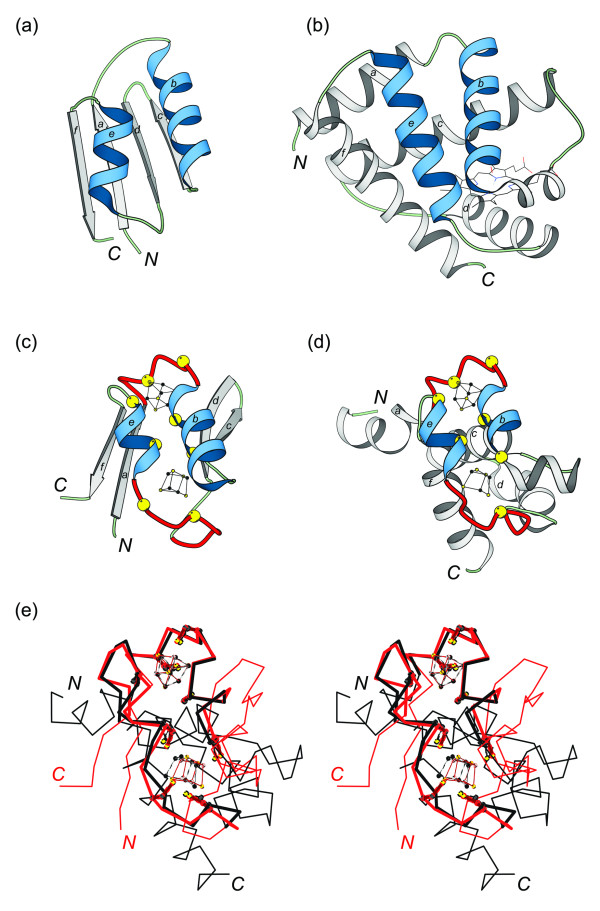
Structural comparison of the ferredoxin domains: Structural diagrams of (a) CheY-binding domain of CheA that belongs to the α+β ferredoxin-like fold (PDB: 1ffg, chain B) and (b) leghemoglobin (PDB: 2 gdm, chain A) that belongs to the globin-like fold. The structures of (c) bacterial ferredoxin domain that adopts the α+β ferredoxin-like fold and (d) α-helical ferredoxin that adopts the globin-like fold are shown. The Cα atoms of the cysteine residues that ligate [4Fe-4S] ([3Fe-4S]) clusters are shown in CPK (yellow). The loops and helices that contribute to cluster-binding are colored red (loops) and cyan (helices), respectively. Other elements are colored grey. (e) Stereo diagram of the structural superposition of a bacterial ferredoxin (1feh, red) [36] with a α-helical ferredoxin (1kf6, black). The structures were superimposed using the program insightII by manually defining equivalent residue pairs, which are shown as thick lines (1feh, chain A: 145–157, 188–205; 1kf6, chain B: 146–158, 202–219; RMSD 0.98 Å). All figures were made using the program BOBSCRIPT [37].